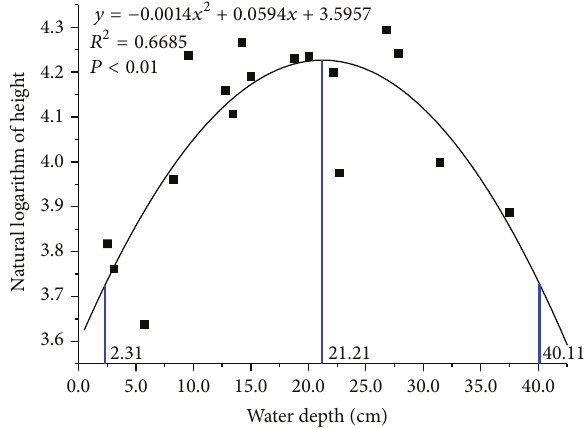
Figure 4: The secondary nonlinear regression based on Gaussian Mode of Carex lasiocarpa populations height and water